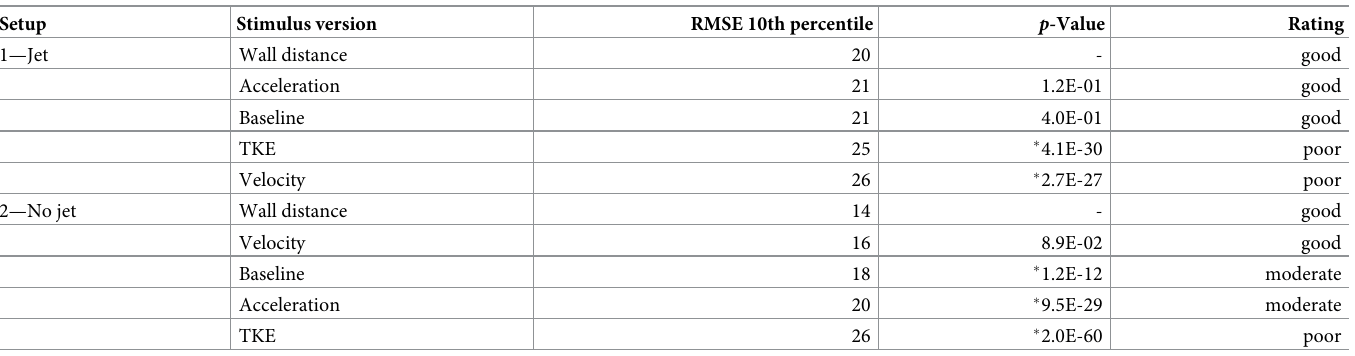
Table 3. Stimulus versions ranked by their RMSE 10 th percentile, per setup. Setup